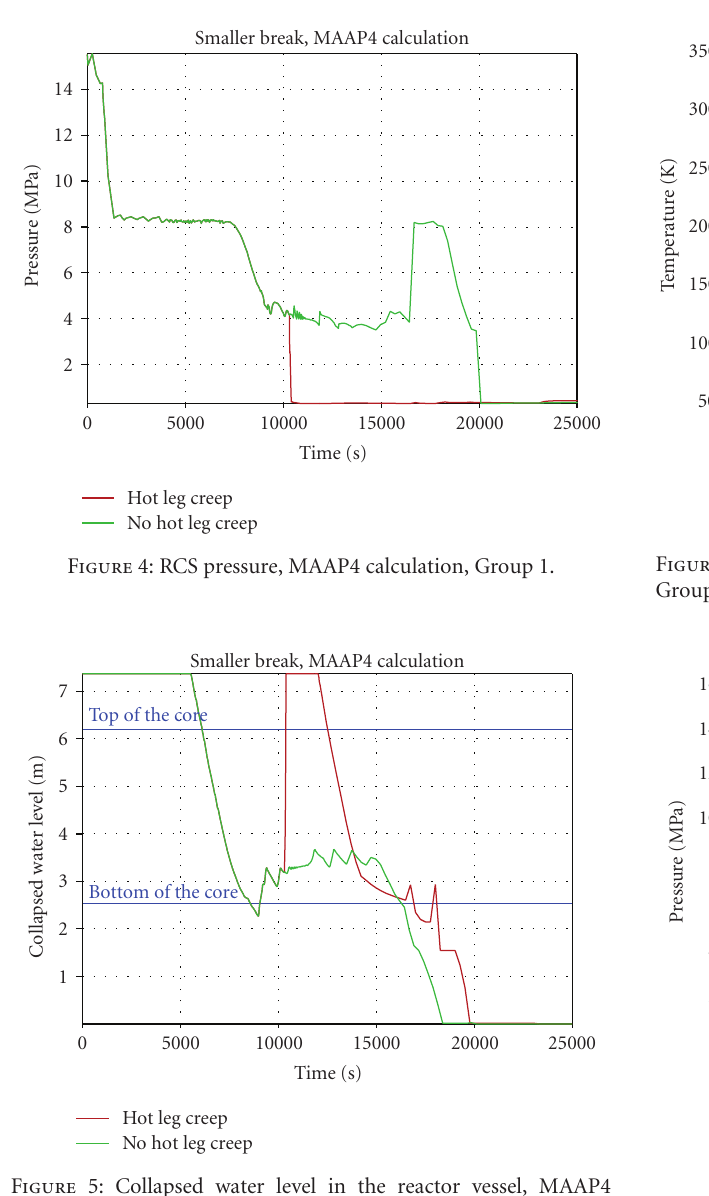
Figure 7: RCS pressure, Group